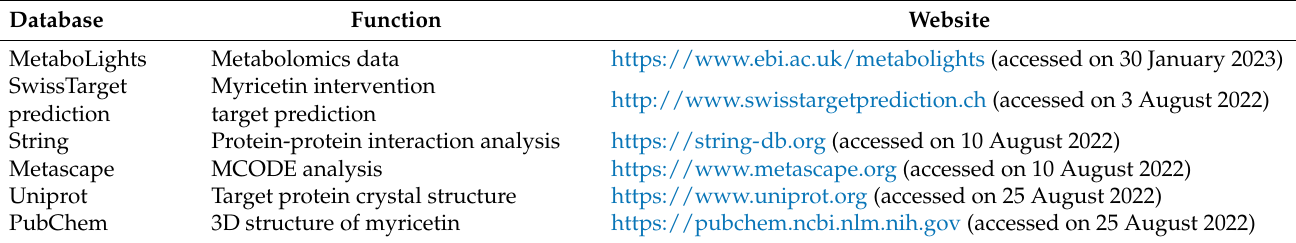
Table 1. Databases used in the study.